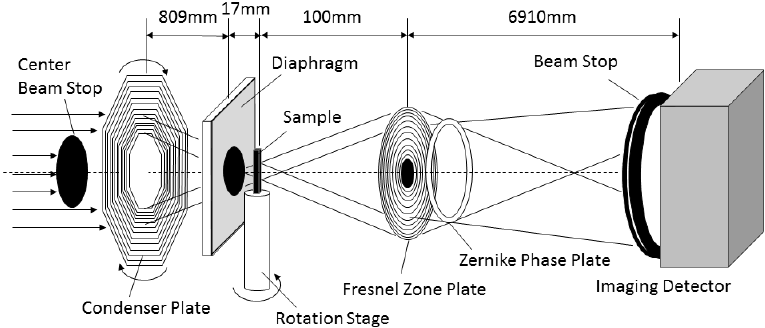
Figure 2. The schematic illustration of set-up of nanotomography in the experimental hutch.